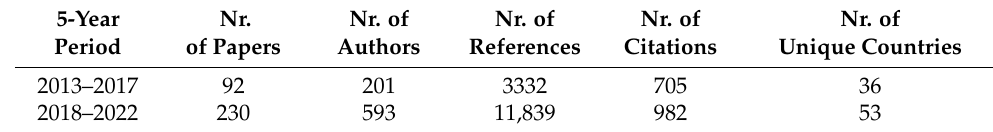
Table 3. Descriptives of the 5-year periods 2013–2017 and 2018–2022 of Publications